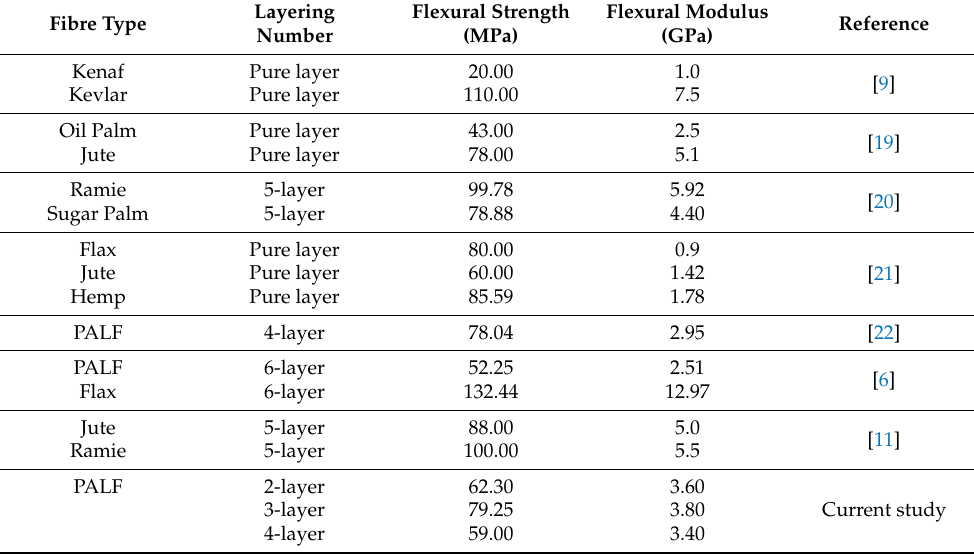
Table 3. Results of previous studies on the flexural properties of fibre-reinforced epoxy composites at different layering numbers.